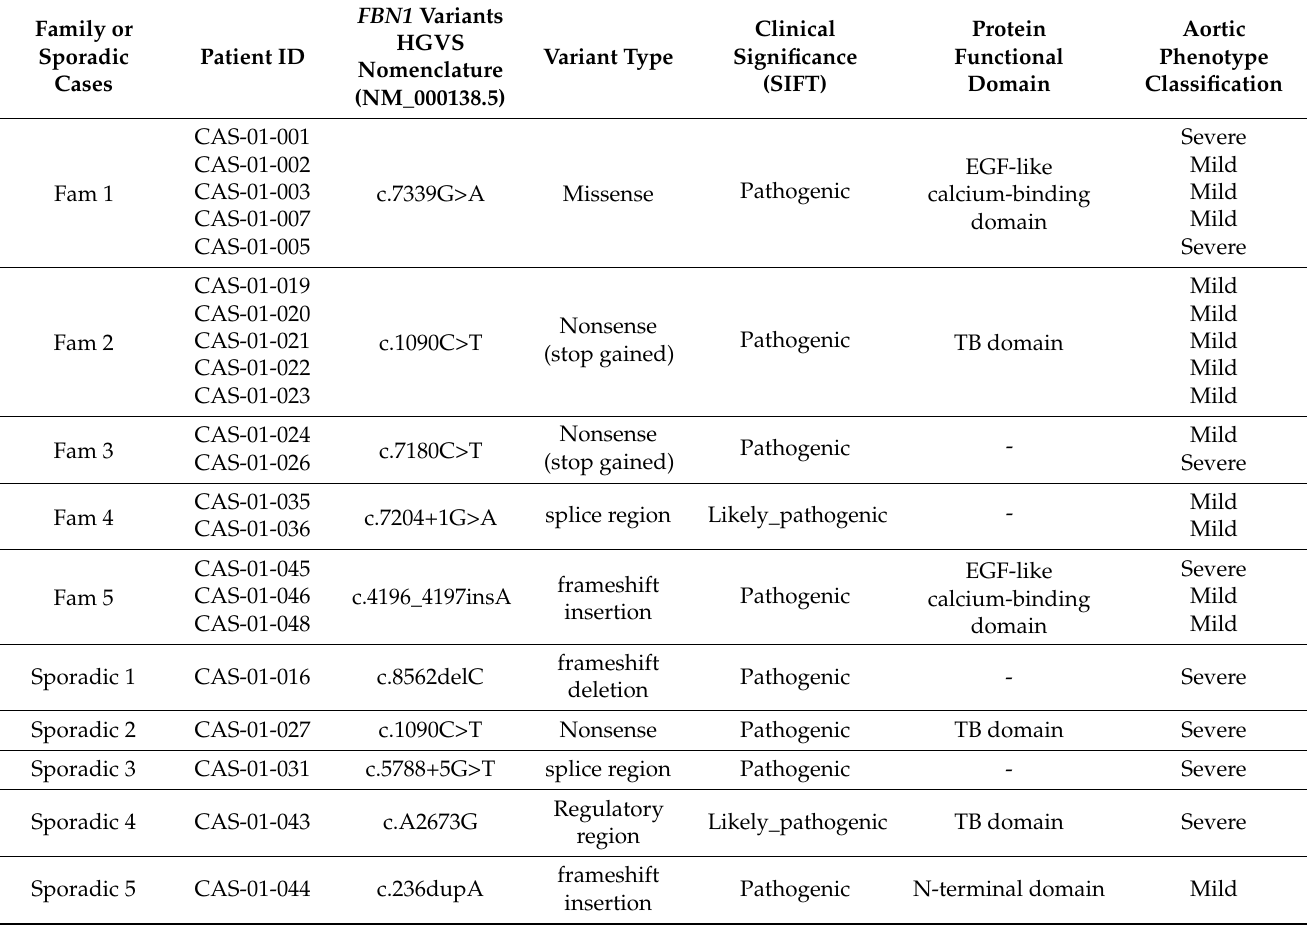
Table 1. Identification of MFS-causing, pathogenic variants in FBN1 in study